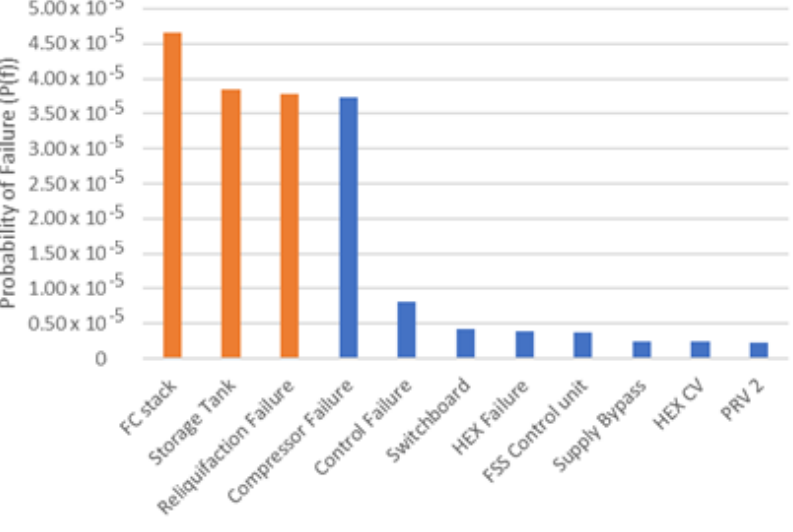
Figure 8. Probability of failure systems and subsystems.